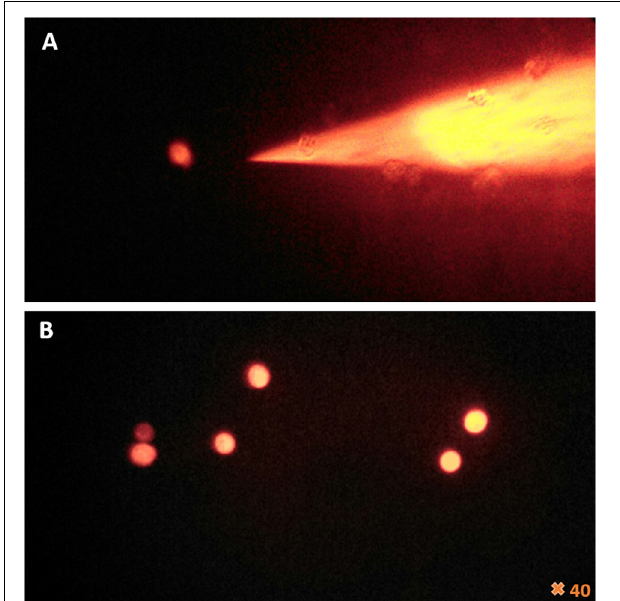
FIGURE 2 | Fluorescence microscopy of the femtotips and the cell’s reaction to microinjection. (A) Illustration of femtotips removed from microinjected amoeba. (B) Observation of amoeba stained in red by rhodamine-dextran and the effect of the microinjection which induces the loss of amoeba adherence and their